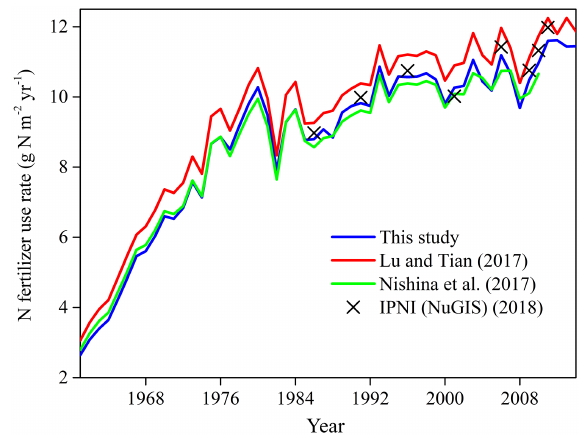
Figure 8. Time series of N fertilizer use in the US: national com- mercial N fertilizer consumption in the US from 1961 to 2014 de- rived from four datasets. Red line: this study; green line: Lu and Tian (2017); blue line: Nishina et al. (2017); and × : IPNI (2018). The N fertilizer consumption derived from Lu and Tian (2017) covers all states and territories of the US, whereas the other three datasets only cover the contiguous US.